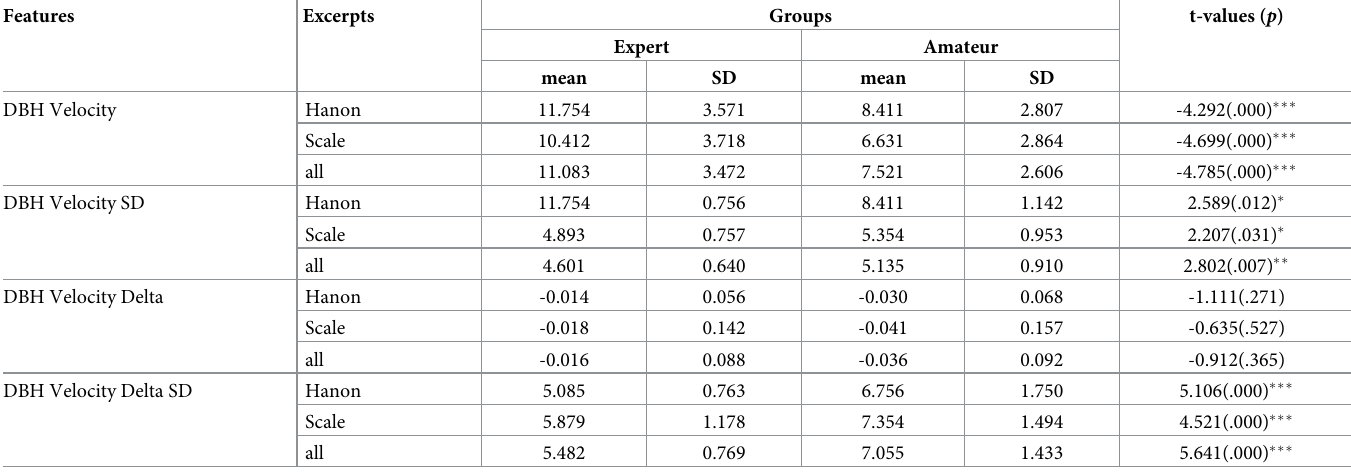
Table 5. Independent-t test statistics and p -value of the two groups (expert and amateur).